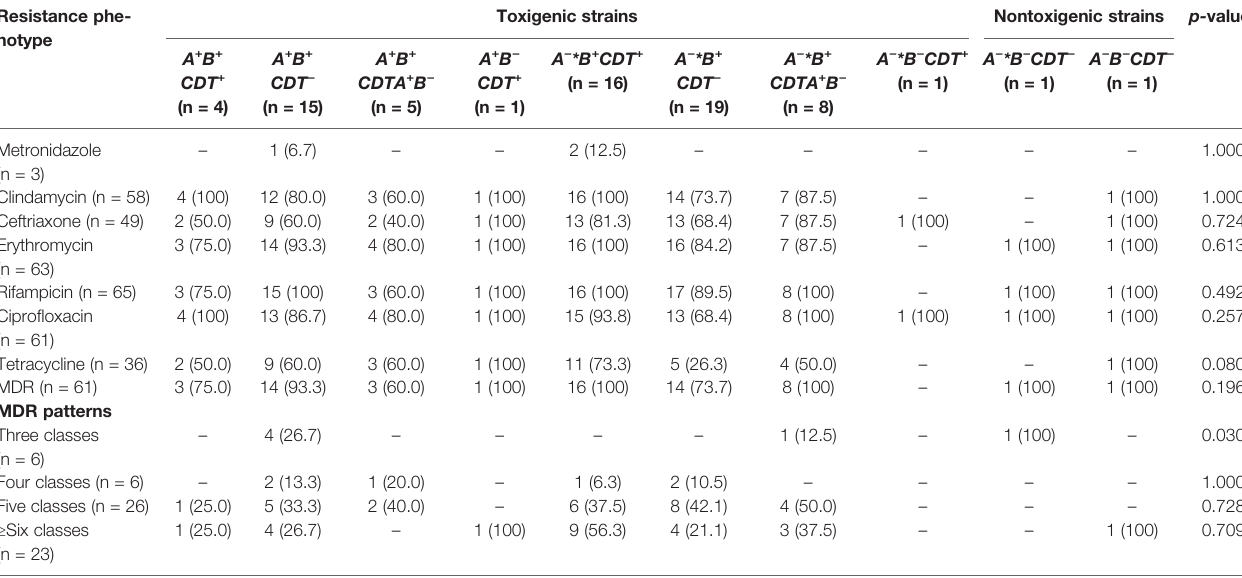
Toxigenic strains Nontoxigenic